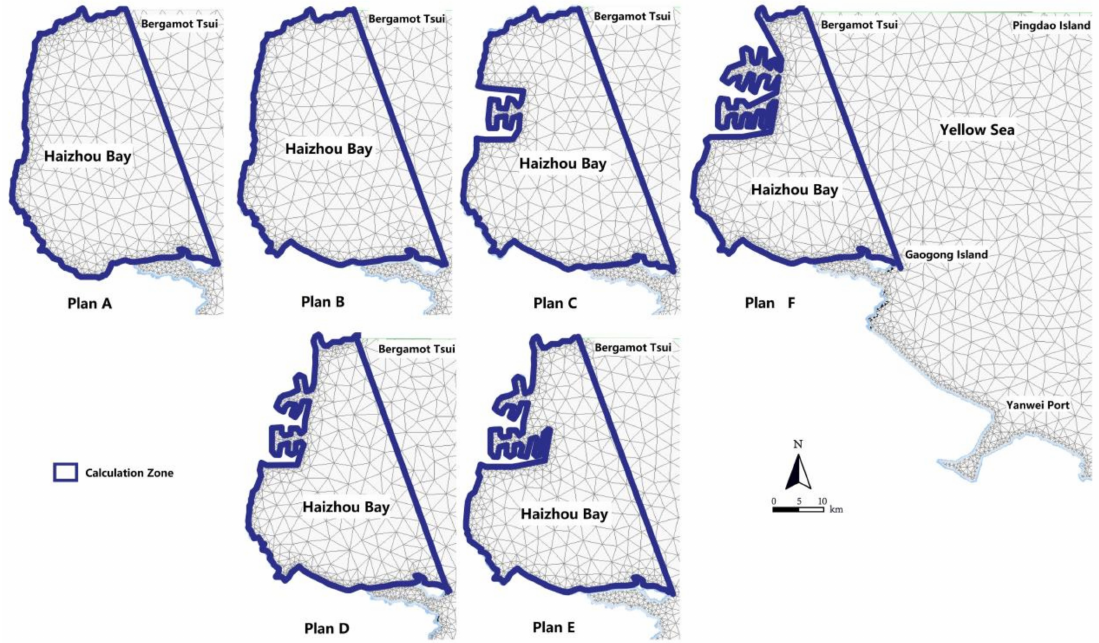
Figure 7. Computed region of marine EC (scenario 1). Computed region of plan A; computed region of plan B; computed region of plan C; computed region of plan D; computed region of plan E; computed region of plan